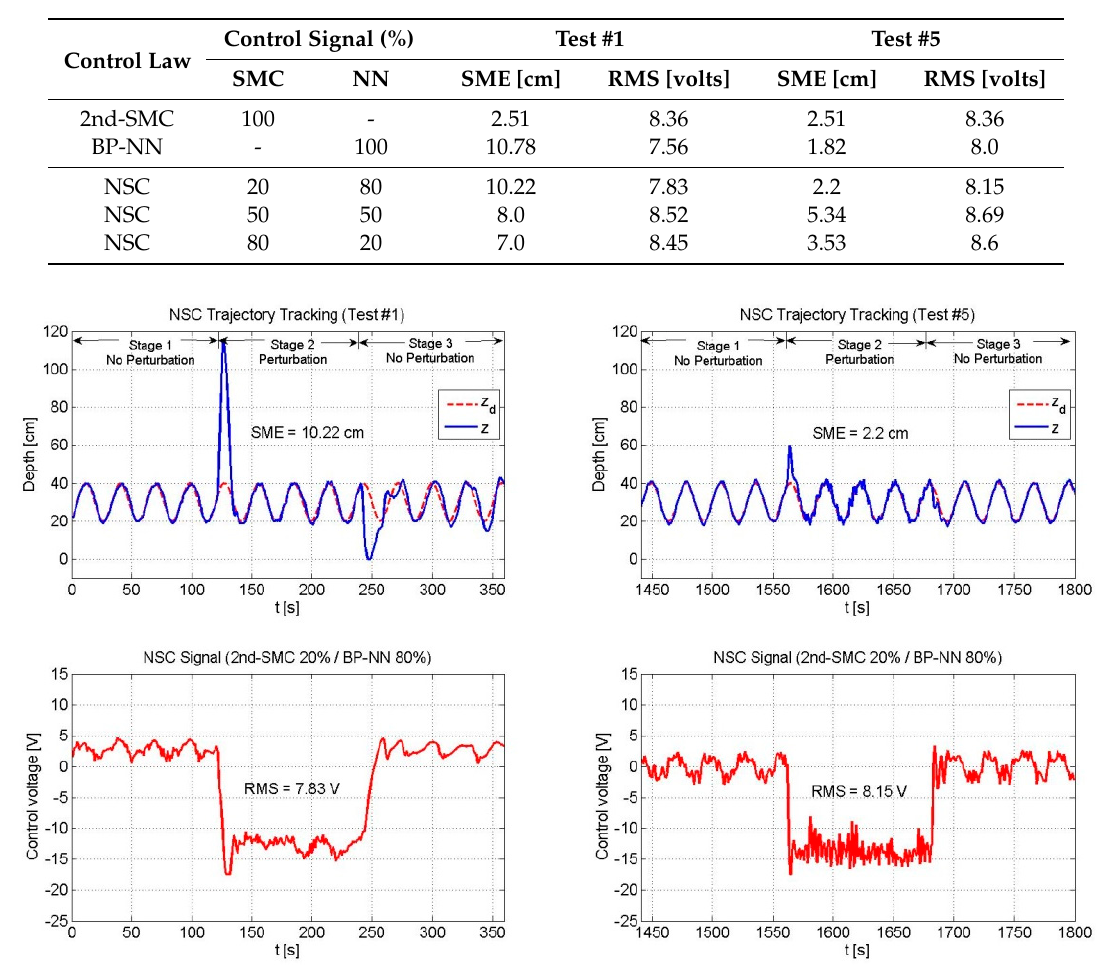
Figure 14. Performance of the NSC scheme (2nd-SMC 50%/BP-NN 50%).